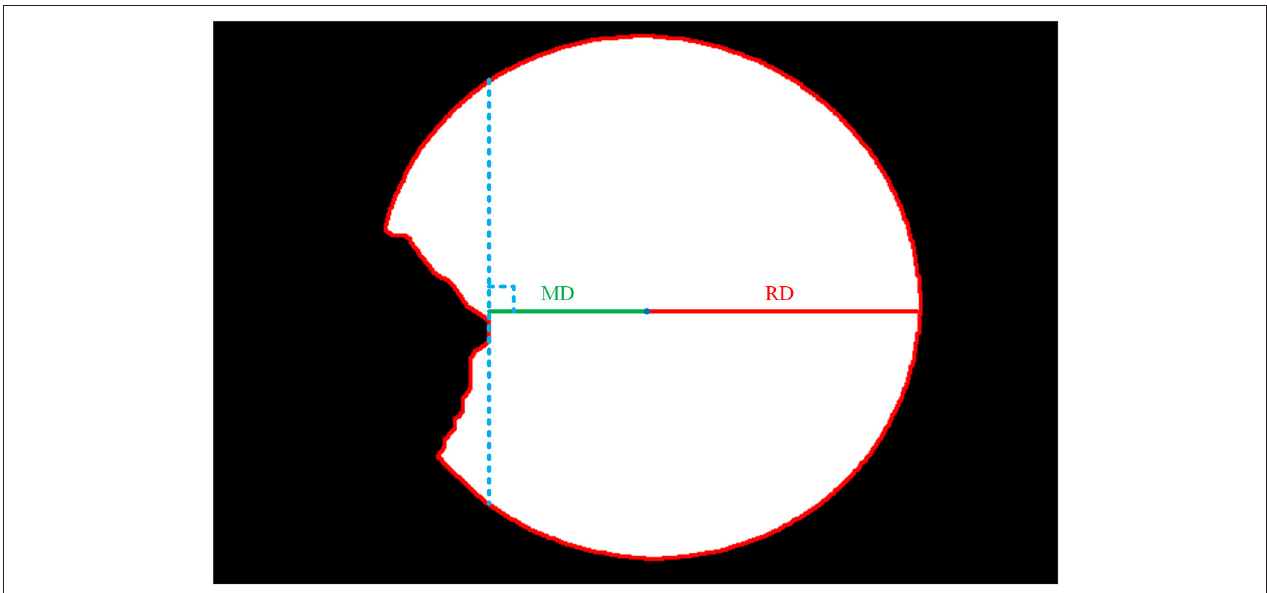
FIGURE 6 | Cornea images not invaded by